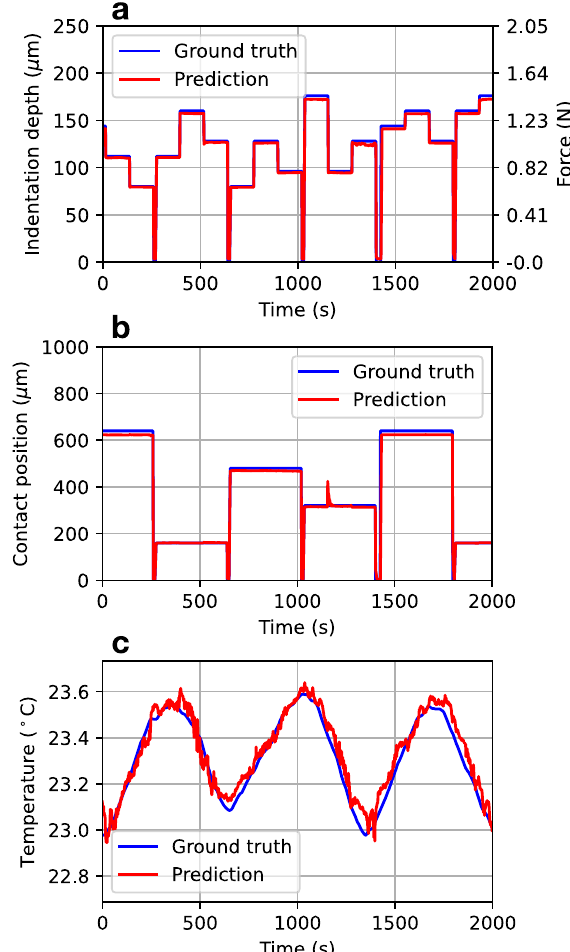
Figure 3. Multimodal sensing demonstration. Simultaneous estimations of (a) indentation depth, (b) contact position, and (c) temperature of the silicone material. In (a) , the applied force corresponding to the indentation depth is also shown. In (b) , an instantaneous large error at 1156 s is mainly attributed to an unintentional deviation from the set position of the indenter. The sensing data points were sampled at time steps of approximately 1.6